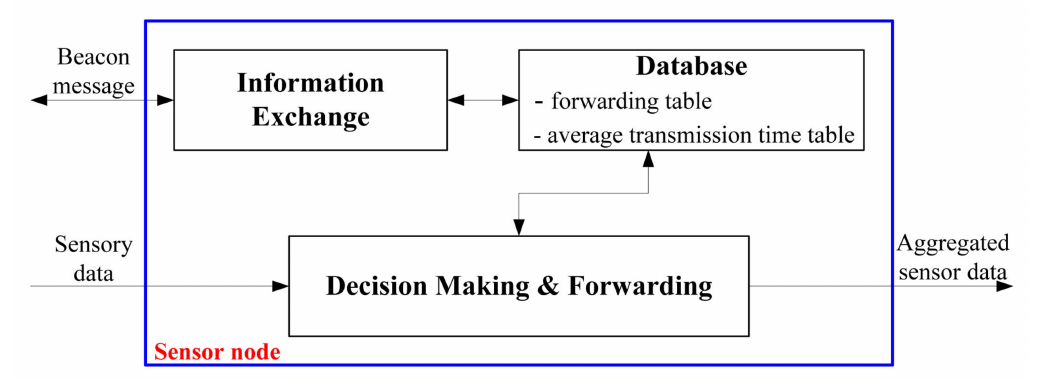
Figure 1. The architecture of the proposed